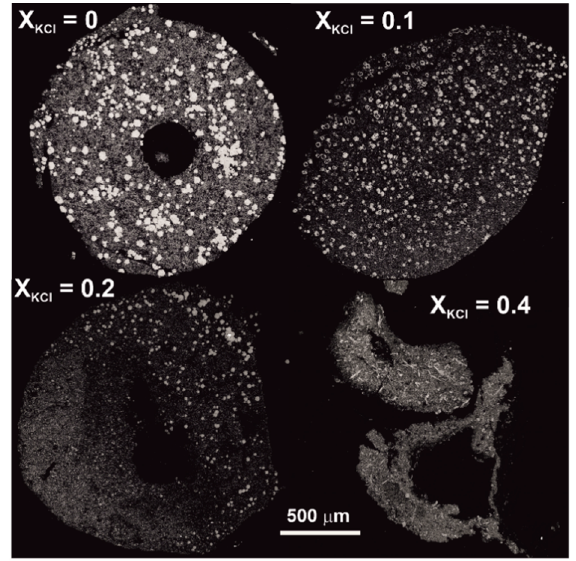
Figure 3. BSE images of the run samples in the system enstatite–pyrope–grossular illustrating a gradual transformation of the garnet-two pyroxene assemblage (X KCl = 0) to clinopyroxene–phlogopite assemblage (X KCl = 0.4) with the increasing KCl content in the aqueous-salt fluid at 5 GPa and 1000 ◦ C. The presence of silicate melt in the run products is not excluded.